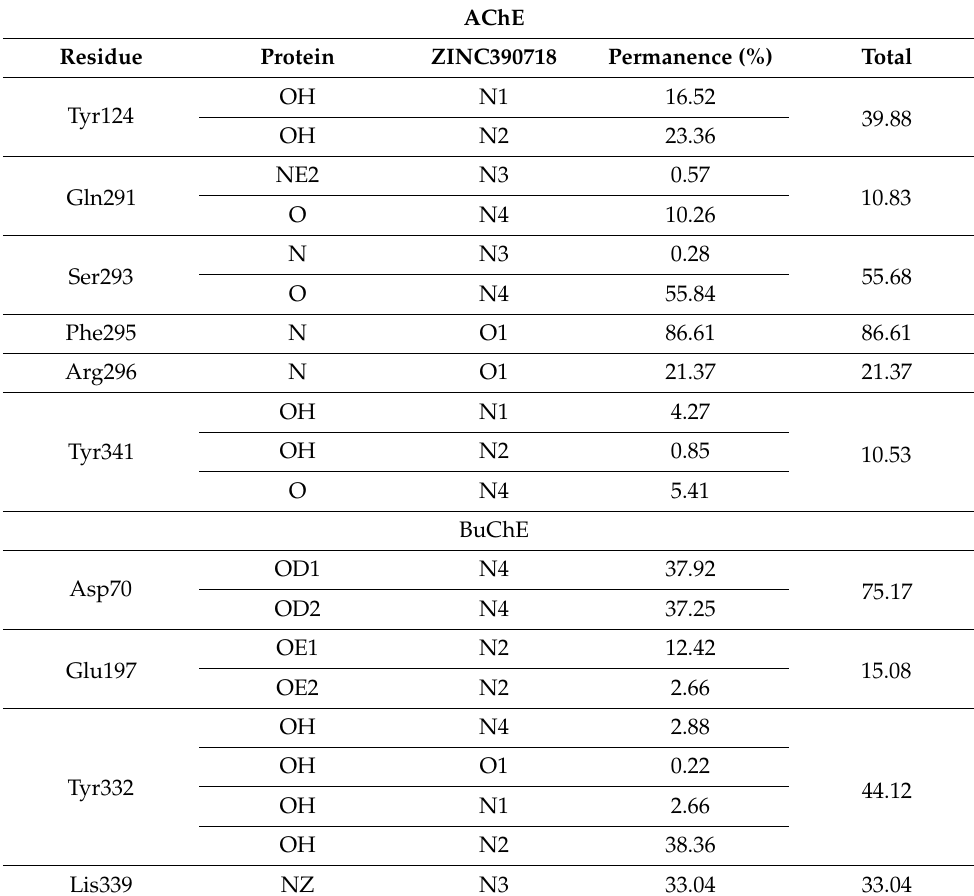
Table 1. Permanence time of hydrogen interactions (H bond ) in the active sites of AChE and BuChE during the production phase and identification of the pairs